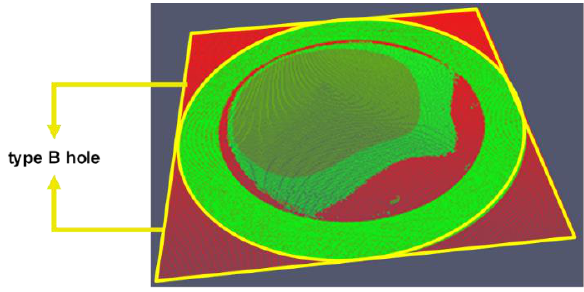
Figure 22. Type-A hole. Illustration on Patient002.